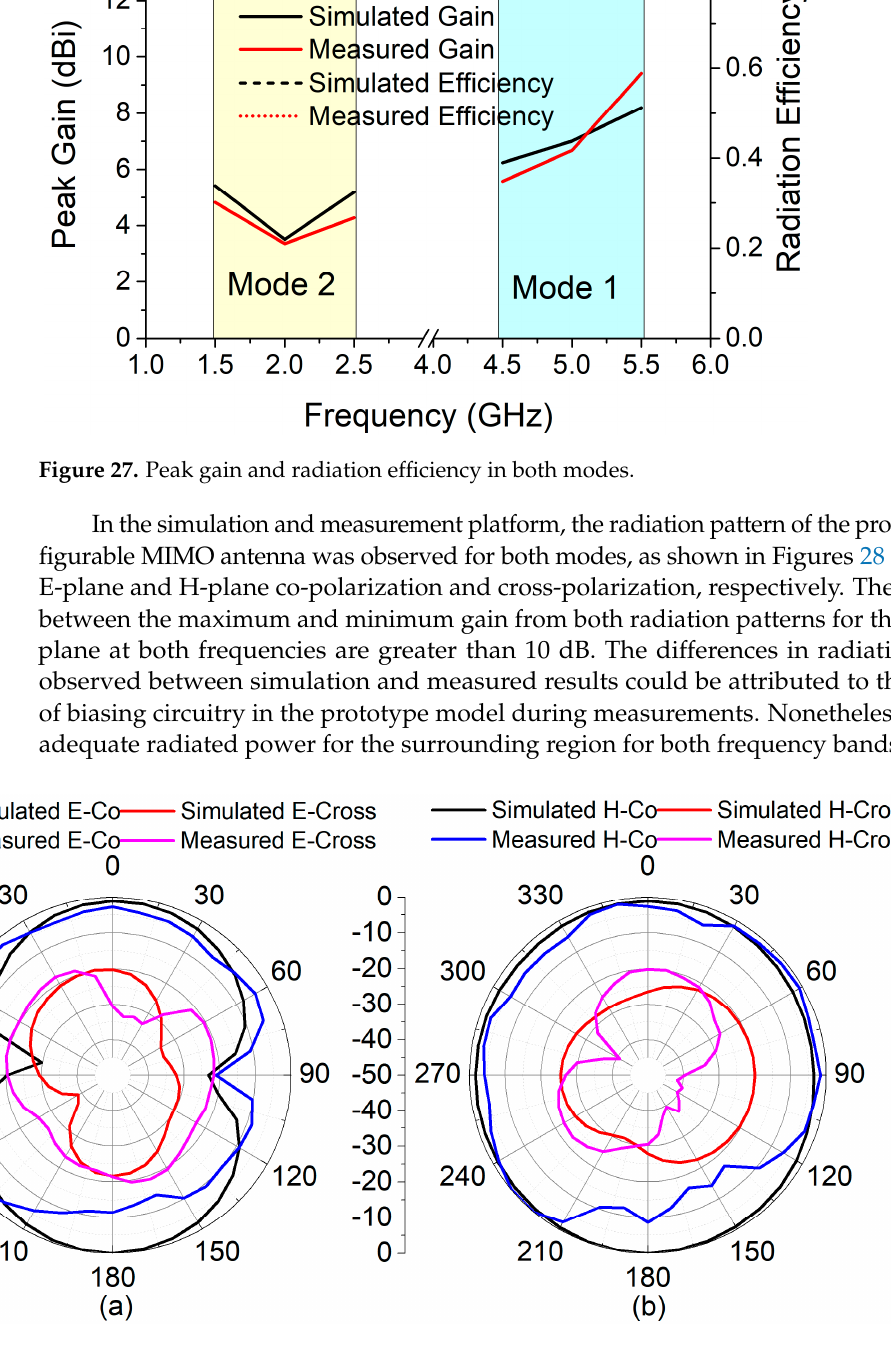
Figure 26. Anechoic chamber measurement setup for measuring the radiation pattern.